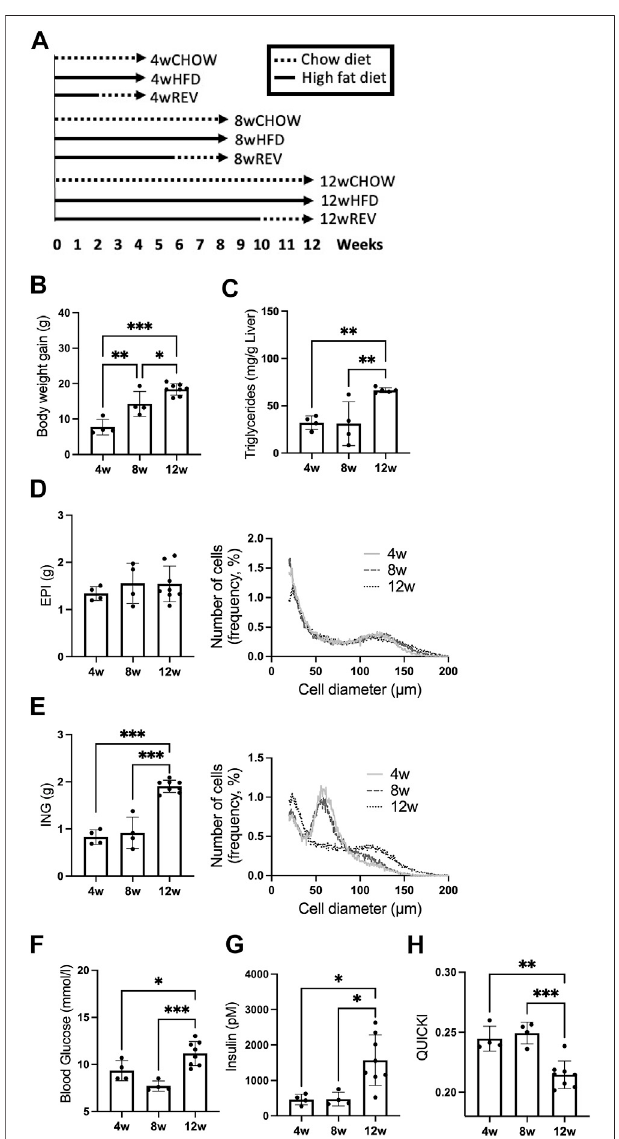
FIGURE 1 | Study outline and time-resolved effect of HFD-feeding on systemic metabolism and adipocyte expansion. (A) Study outline for time- resolved analysis of HFD-feeding and reversal from HFD to chow. C57BL/6J mice,9 weeksold,weresubjectedtotime-resolvedanalysisfor4,8,and 12 weeks of diet intervention, each time point including the following three groups:CHOW,chow-feedingthroughoutthedietintervention, n =7(4w), n = 10 (8w), n = 9 (12w). HFD, high-fat diet feeding throughout the diet intervention, n = 4 (4w), n = 4 (8w), n = 8 (12w). REV, high-fat diet feeding, switched to chow-feeding during the fi nal 2 weeks of diet intervention, n = 11 (4w), n =5(8w), n =10(12w). (B – H) MicesubjectedtoHFD-feedingfor4,8,or 12 weeks. Final (B) body-weight gain and (C) liver triglycerides (mg/g liver). Final fatdepot weightand adipose cell-sizedistribution of (D) EPIand (E) ING. Cell-size distribution graphs display the percentage of cells (y-axis) and cell diameter (µm) (x-axis), 4w and 8w n = 4/time point, 12w n = 5. (F) Blood glucose (mM), (G) serum insulin (pM), and corresponding (H) QUICKI. Data are displayed as mean ± SD and one-way ANOVA, Tukey ’ s post-hoc test, was used as statistical analysis. Signi fi cance was determined according to * p ≤ 0.05, ** p ≤ 0.01 and *** p ≤